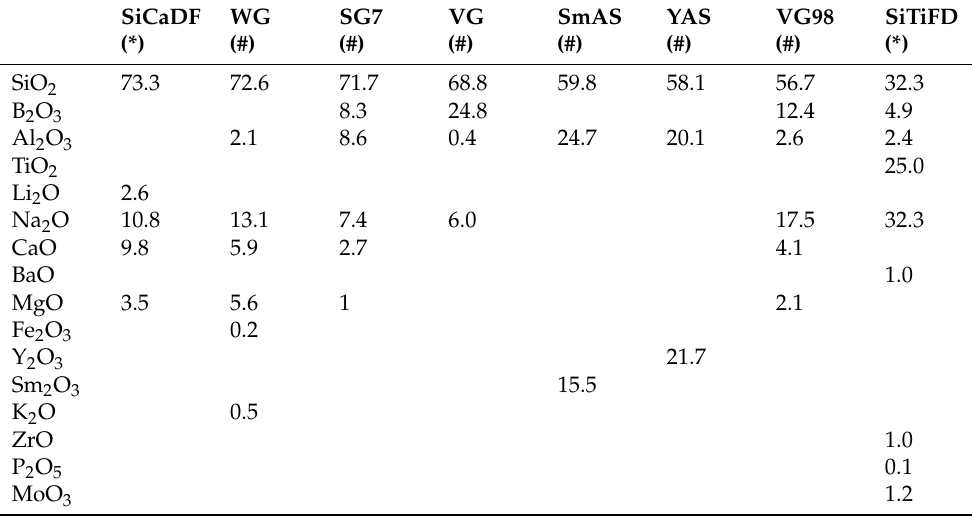
Table 1. Glass compositions mol%. (*) nominal, (#) as determined in this work using EDS. Glasses are ordered according to decreasing silica